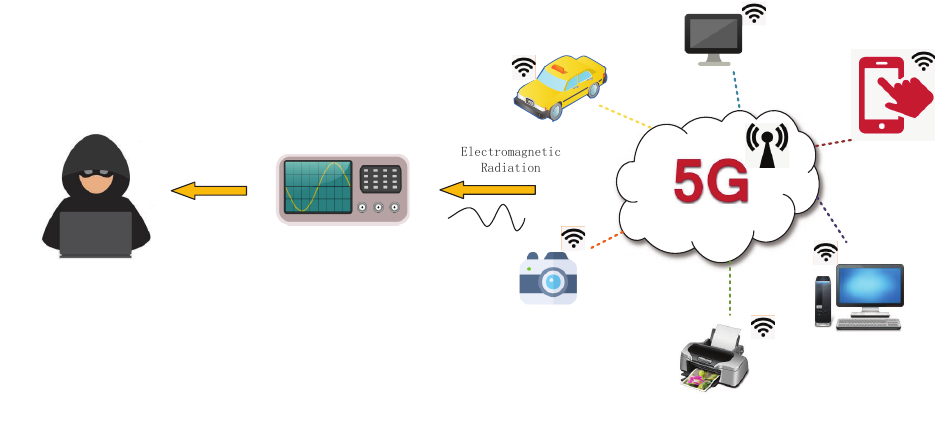
Figure 1. Information security in communication